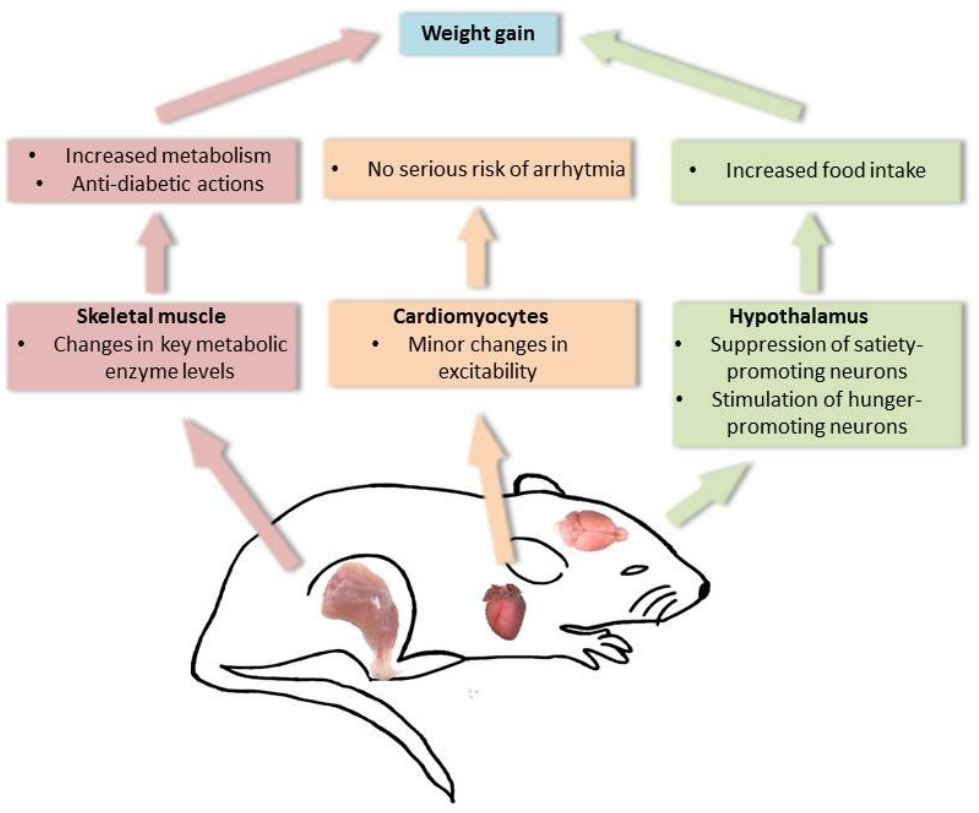
Figure 7. Proposed mode of action of AX in mice. Summary of our findings on the responses by AX on skeletal muscle metabolism, cardiac excitability and hypothalamic neuronal activity that could lead potentially to weight gain. AX facilitates the increase in metabolism and exerts anti-diabetic actions on skeletal muscle, promotes food intake via actions on the hypothalamus, and exerts minor changes on cardiac excitability.